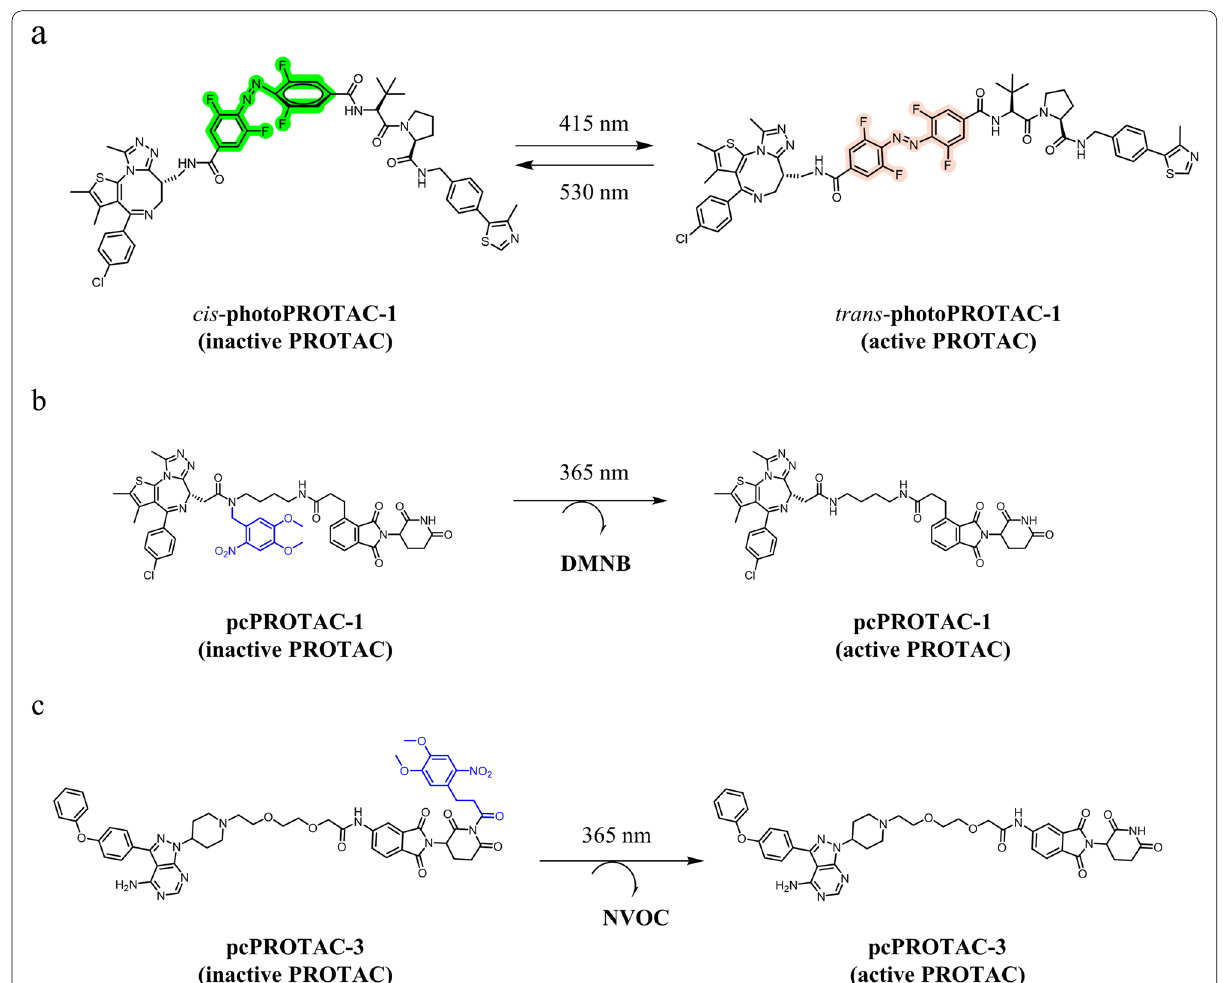
Fig. 4 a photoPROTAC-1 comprising BRD-targeting JQ1 and a VHL ligand linked via a photoswitchable tetrafluoro azobenzene moiety. Light irradiation converts the inactive cis-photoPROTAC-1 into its active trans isomer, and vice versa, b irradiation of DMNB-protected PROTAC at 365 nm releases potent BET degrader dBET1, c irradiation of NVOC-protected PROTAC at 365 nm releases potent BTK